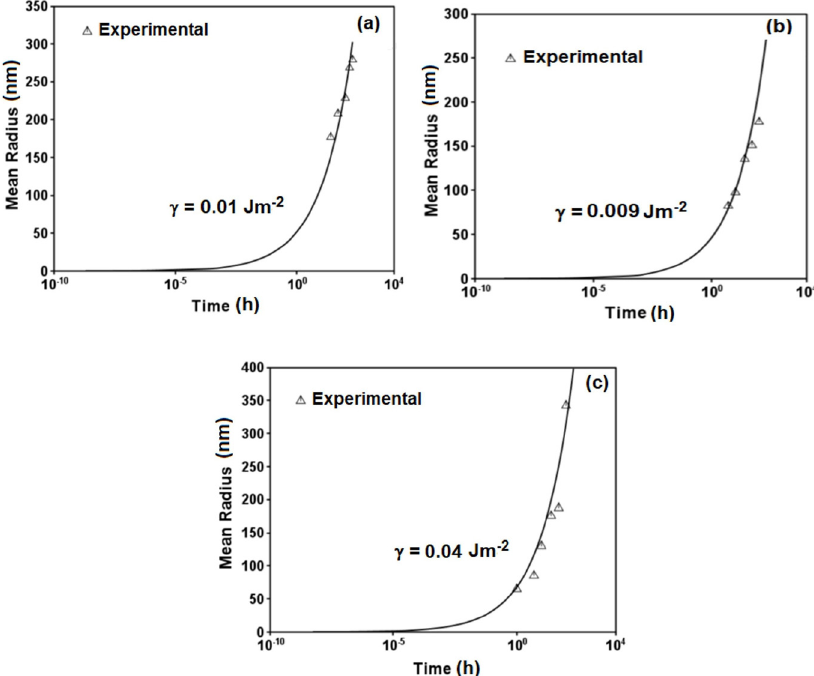
Figure 10. Precipitation/Kinetic software calculated curve and experimental values of average radius vs. time for the (a) Fe-10at.%Ni- 15at.%Al, (b) Fe-10at.%Ni-15at.%Al-2.5at.%Cu and (c) Fe-10at.%Ni-15at.%Al-5at.%Cu alloys aged at 850